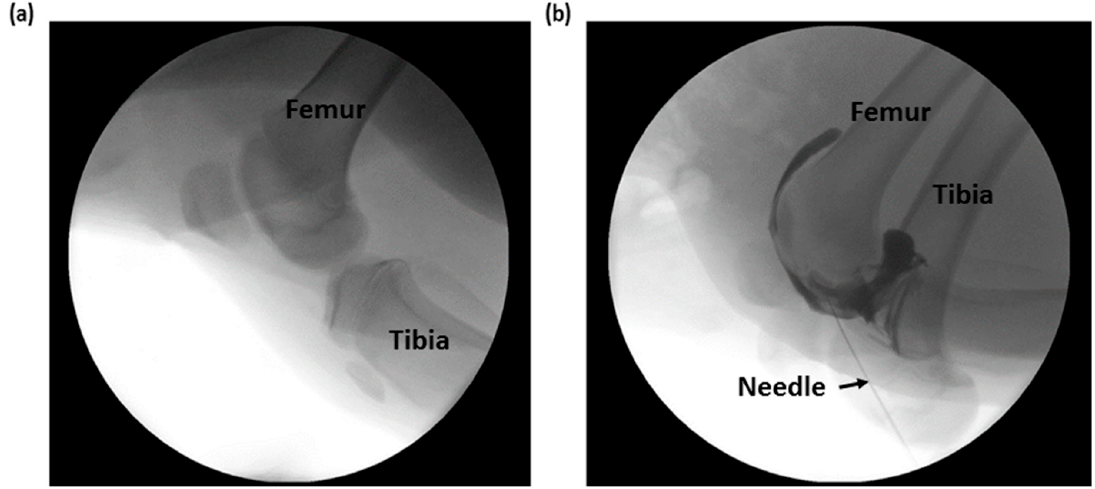
Figure 9. X-ray images by fluoroscopy ( a ) before and ( b ) after injection of contrast in the intra-articular space.